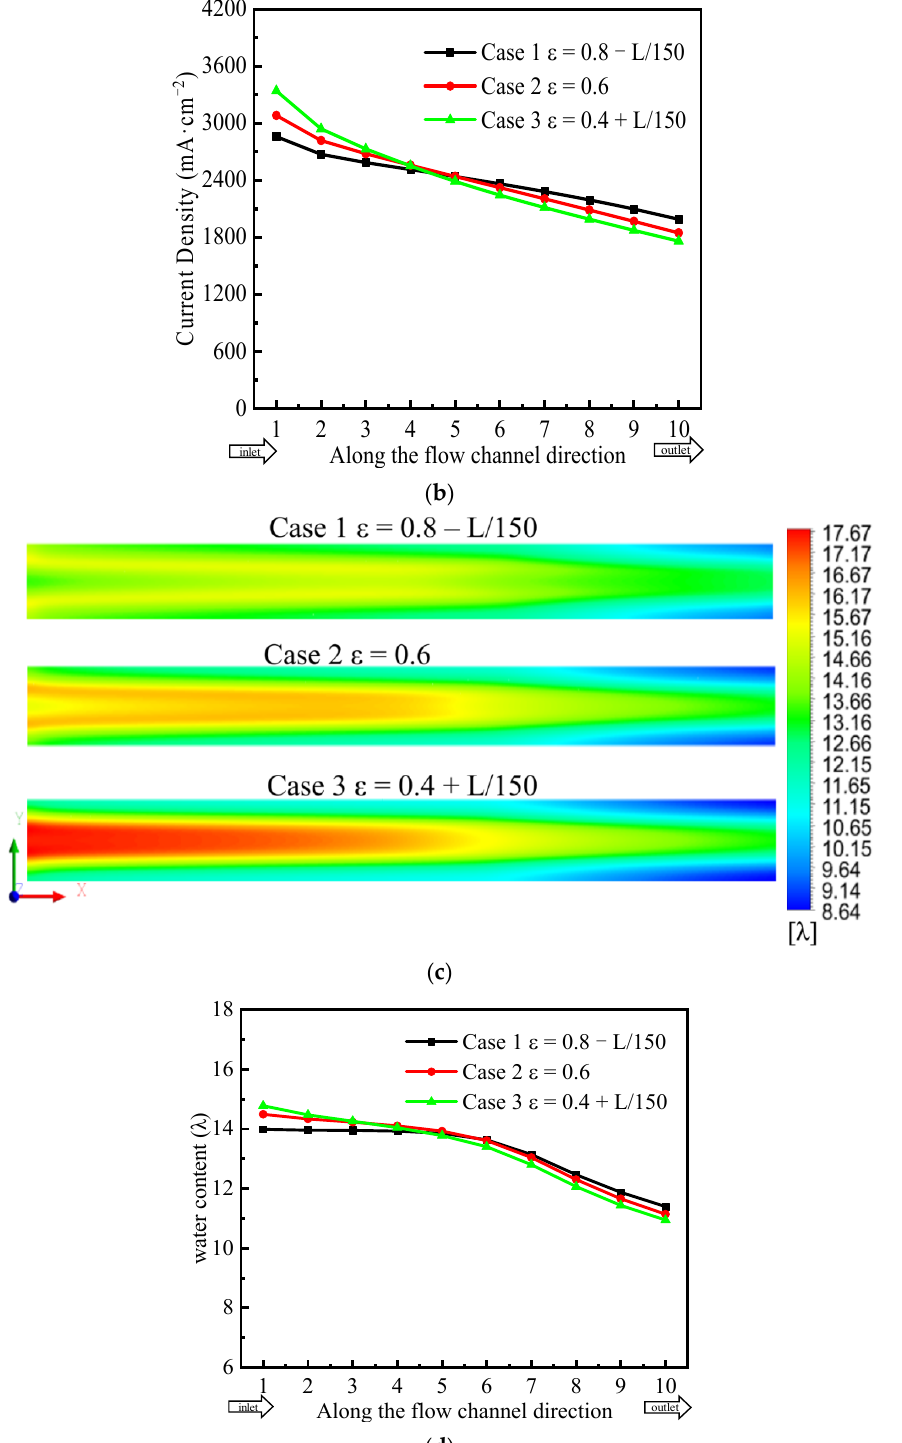
Figure 9. Distribution of the ( a , b ) current density and ( c , d ) water content at the 1/2 thickness of the membrane for the three